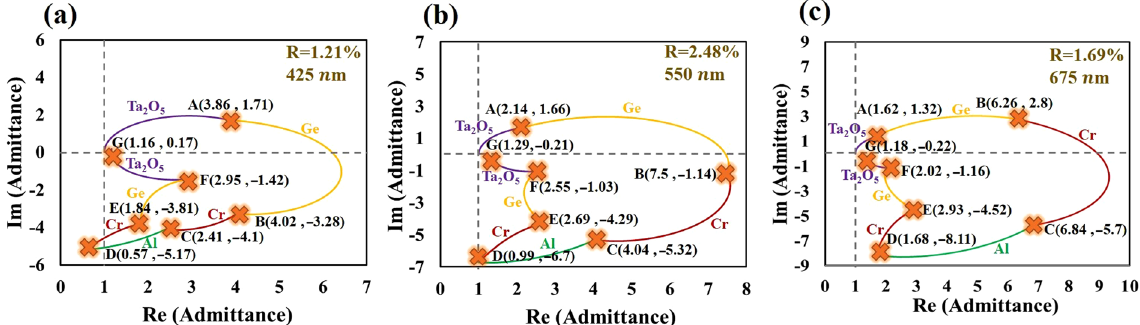
Figure 8. Normalized admittance diagram of Air/Ta 2 O 5 (40 nm)/Ge(20 nm)/Cr(15 nm)/Al(30 nm)/Cr(15 nm)/ Ge(20 nm)/Ta